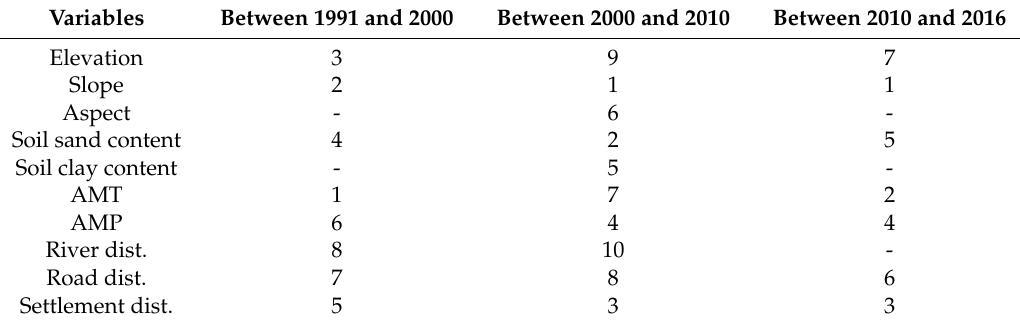
Table 5. Potential drivers of farmland expansions in the three LR models placed in order of importance. Variables Between 1991 and 2000 Between 2000 and 2010 Between 2010 and 2016 Elevation 3 9 7 Slope 2 1 1 Aspect - 6 - Soil sand content 4 2 5 Soil clay content - 5 - AMT 1 7 2 AMP 6 4 4 River dist. 8 - Road dist. Settlement dist.